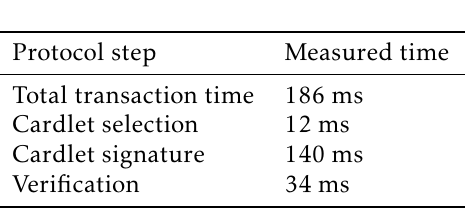
Table 5. Execution times of our